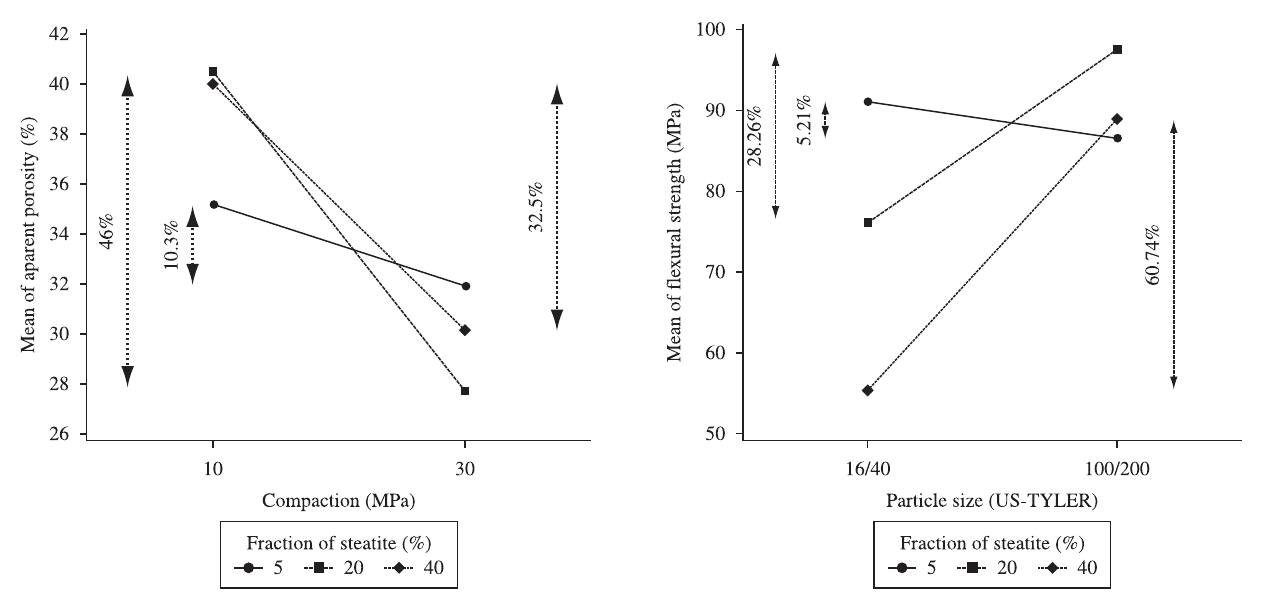
Figure 3. Interaction effect plot for apparent porosity, fraction of steatite and